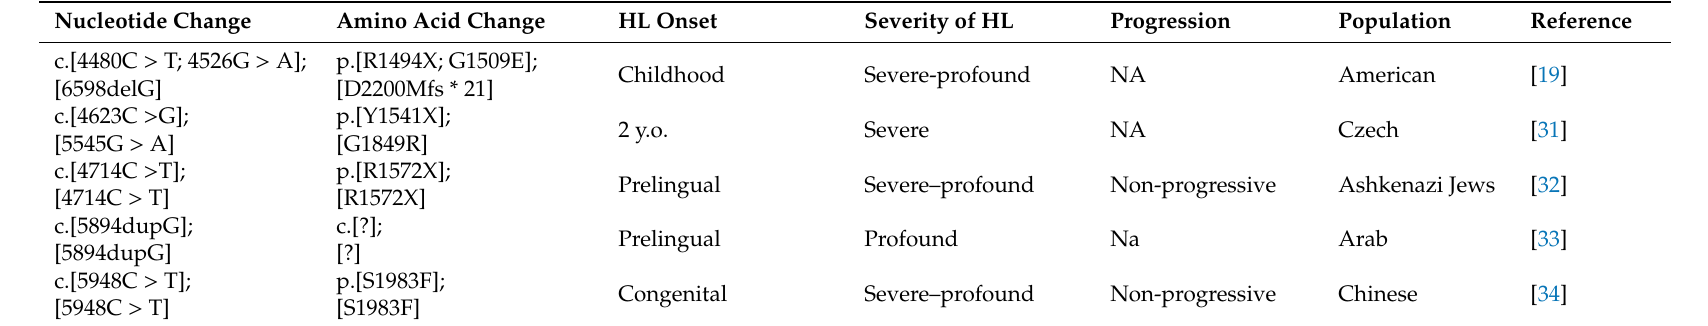
Figure 1. Pedigree and audiograms for each family with LOXHD1 variants. Arrows show the probands in each family (family numbers 1–25). Genetic findings for each individual tested are noted in the pedigree. The age at the time of their genetic and audiometric testing is noted below the audiogram. ＊ These families include the variations mentioned in the footnote of Table 1. Phasing of the three variants were unknown. * This asterisk indicates the numbers of